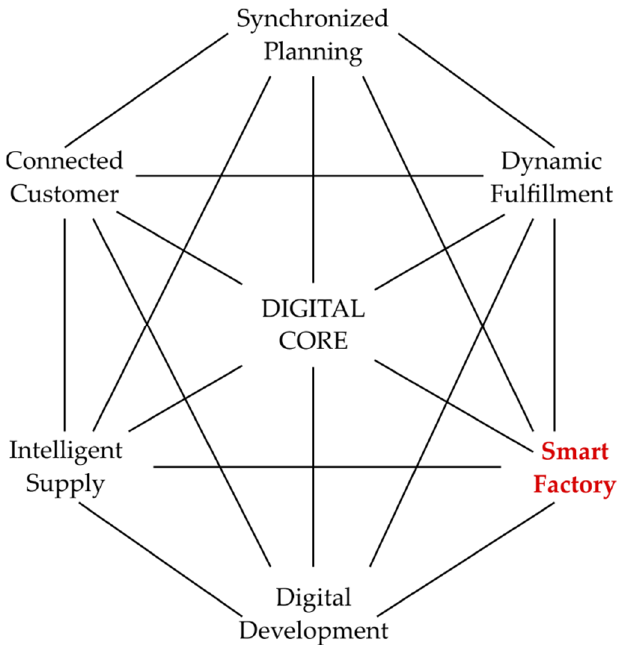
Figure 1. Digital supply chain network.